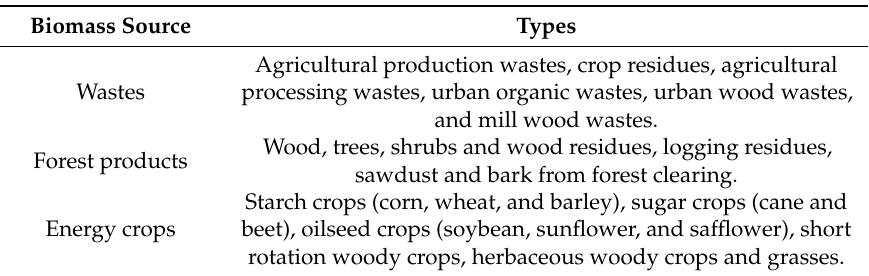
Figure 4. World bioenergy use by sector and use of traditional biomass in the new policy scenario (2010–2035).